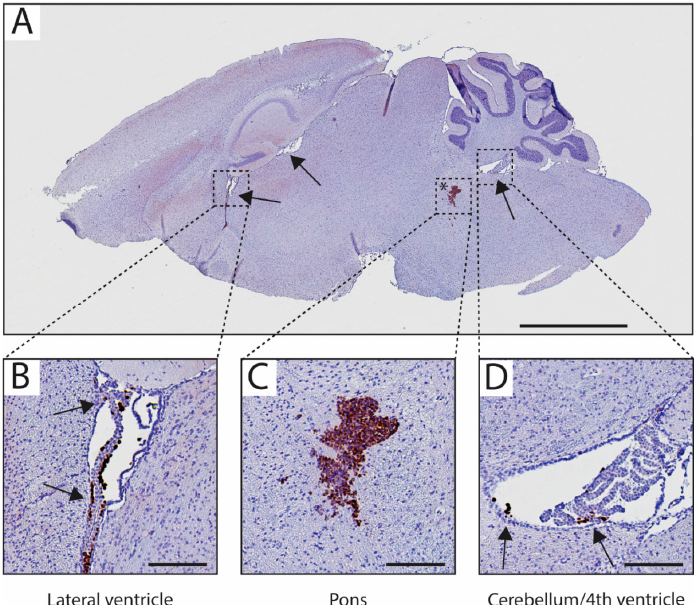
Figure 5. HSJD-DIPG-007 cells within the pons and disseminated throughout the brain immediately following inoculation. ( A ) Matrigel-suspended HSJD-DIPG-007 cells within the pons area (asterisk) as well as in distant brain structures (arrows) at time zero, identified via antihuman vimentin stain- ing. Magnification of HSJD-DIPG-007 cells present in the choroid plexus of the lateral ventricle ( B ), pons ( C ), and choroid plexus of the cerebellum/4th ventricle ( D ). Counterstaining is with haema- toxylin. Scale bar = 2 mm for A , 100 µm for ( B – D ). A comparative histopathological analysis of clinical autopsy-derived DMG with the orthotopic E98 DIPG mouse model was previously performed by Caretti and colleagues [53]. To determine the clinical relevance of the HSJD-DIPG-007 PDX model, we used the histology panel of DMG patient tissue of Carreti et al. for a comparative assessment of disease progression (Figure 6). Perivascular tumour dissemination in the HSJD-DIPG-007 PDX model was seen to be like that observed in the DMG patient (Figure 6C,D). Similari- ties were also observed in brain parenchyma invasion in the HSJD-DIPG-007 model and clinical DMG (Figure 6G,H), as well as vascular proliferation (Figure 6K,L).